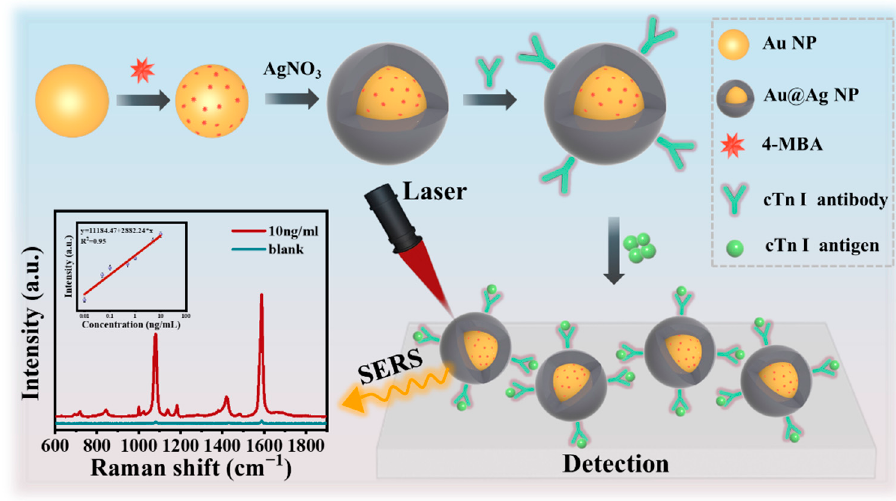
Figure 1. Scheme for the preparation of SERS nanotags and the detection of cTn I.